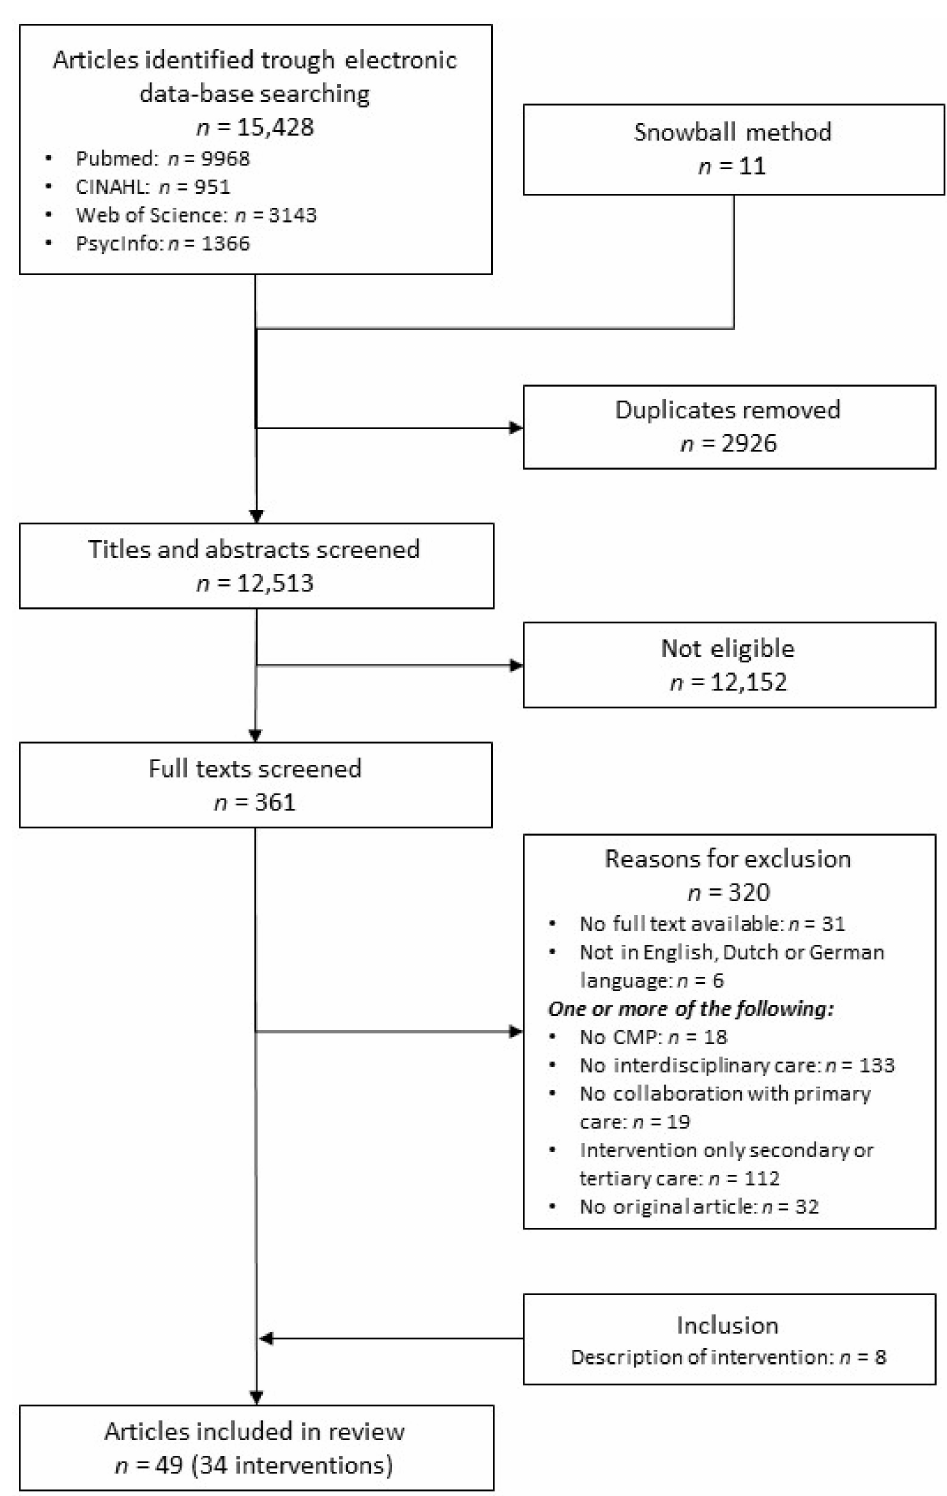
Figure 2. Process of literature